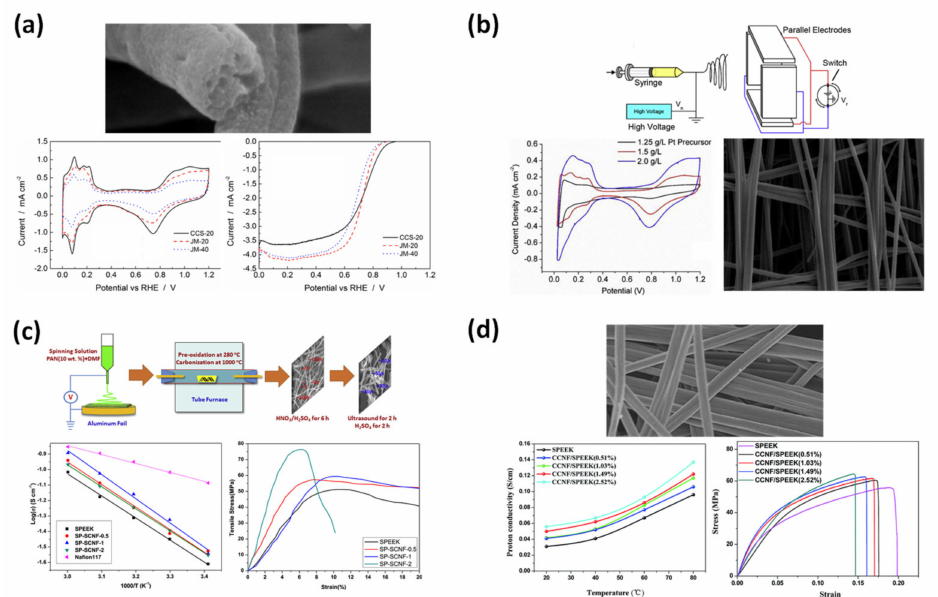
Figure 17. ( a ) MEA constructed of multichannel fibers, carbonization at high temperature [126]. ( b ) Orthogonally aligned CNFs for MEA in fuel cells [127]. ( c ) MEA from the composite of CNFs and SPEEK [128]. ( d ) MEA from the acid − treated CNFs and SPEEK